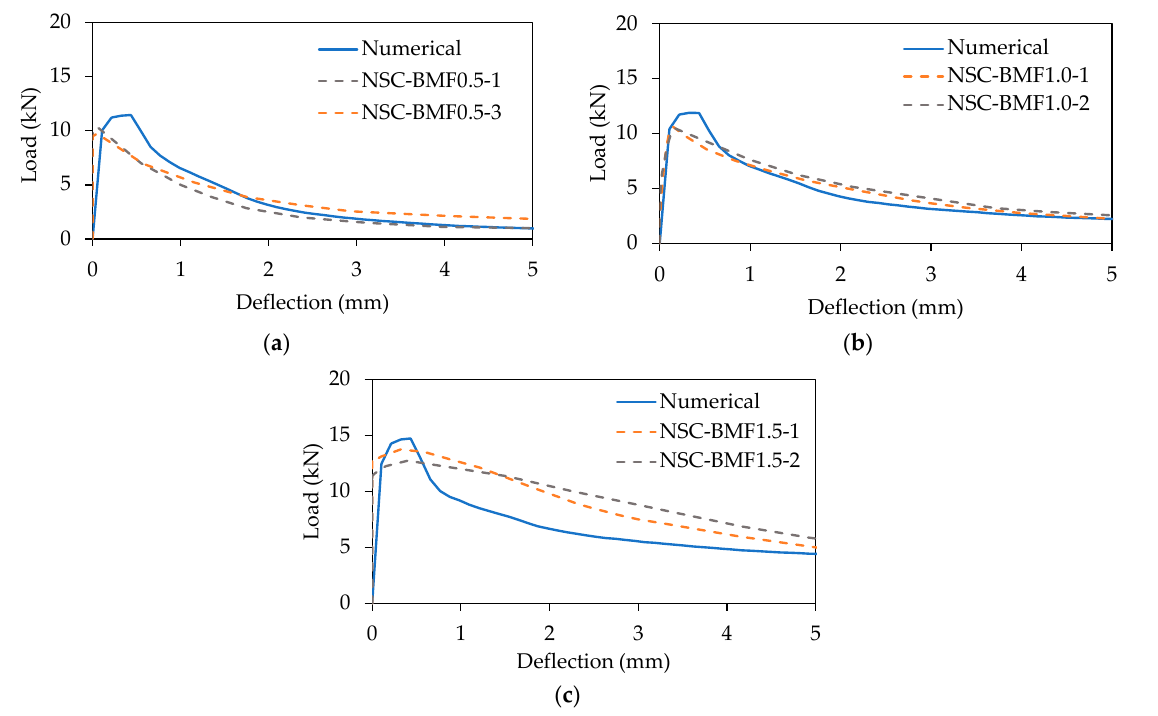
Figure 24. Numerical versus experimental flexural response of NSC: ( a ) ν f = 0.5%; ( b ) ν f = 1.0%; ( c ) ν f = 1.5%.